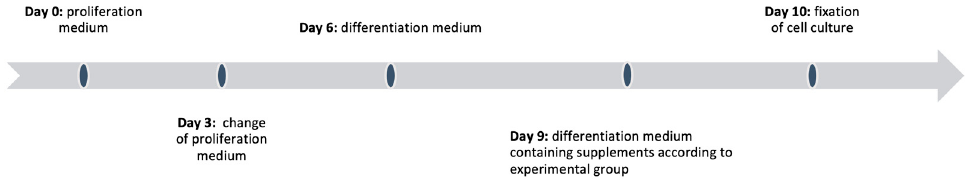
Figure 1. Overview of the di ff erent steps during cultivation of myenteric neurons.